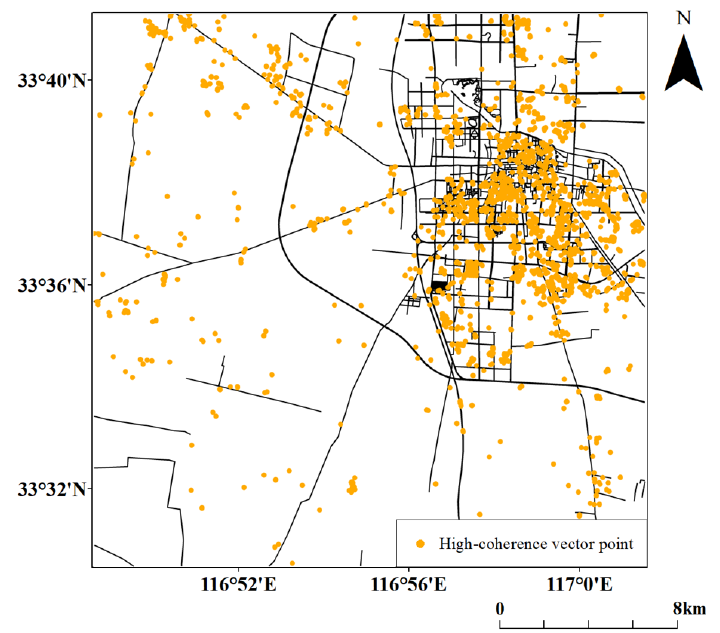
Figure 12. Distribution of high coherence vector